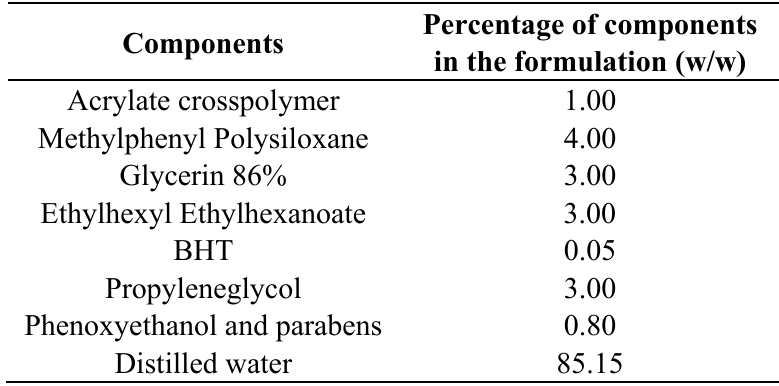
Table 3. Components of the formulation under